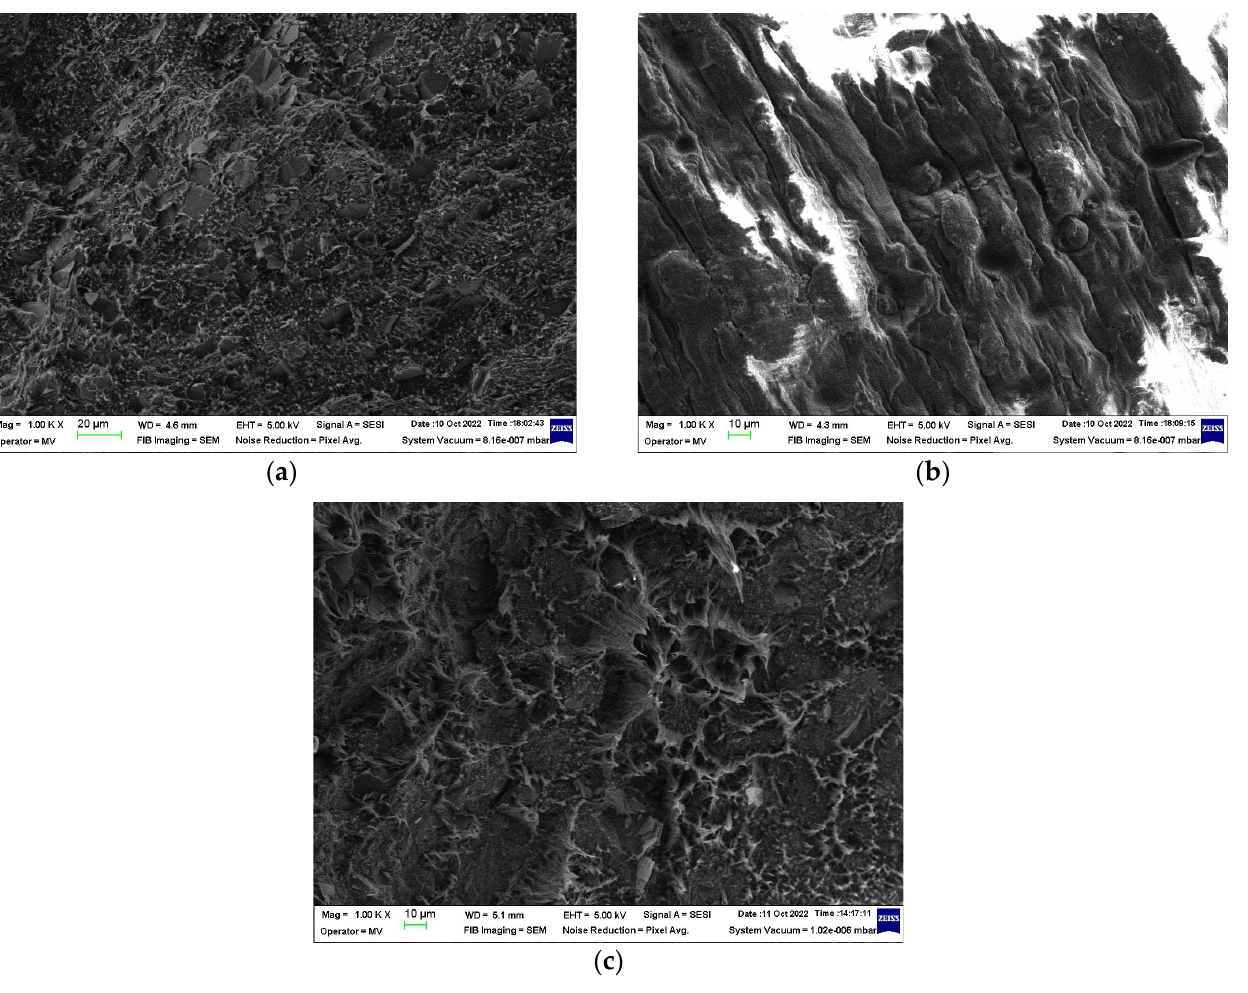
Figure 7. SEM micrographs of (CB + Gr)/HD composite prepared by melt blending followed by: ( a ) press molding; ( b ) injection molding; ( c ) micrography of sample CB + Gr)/(LLD + HD).